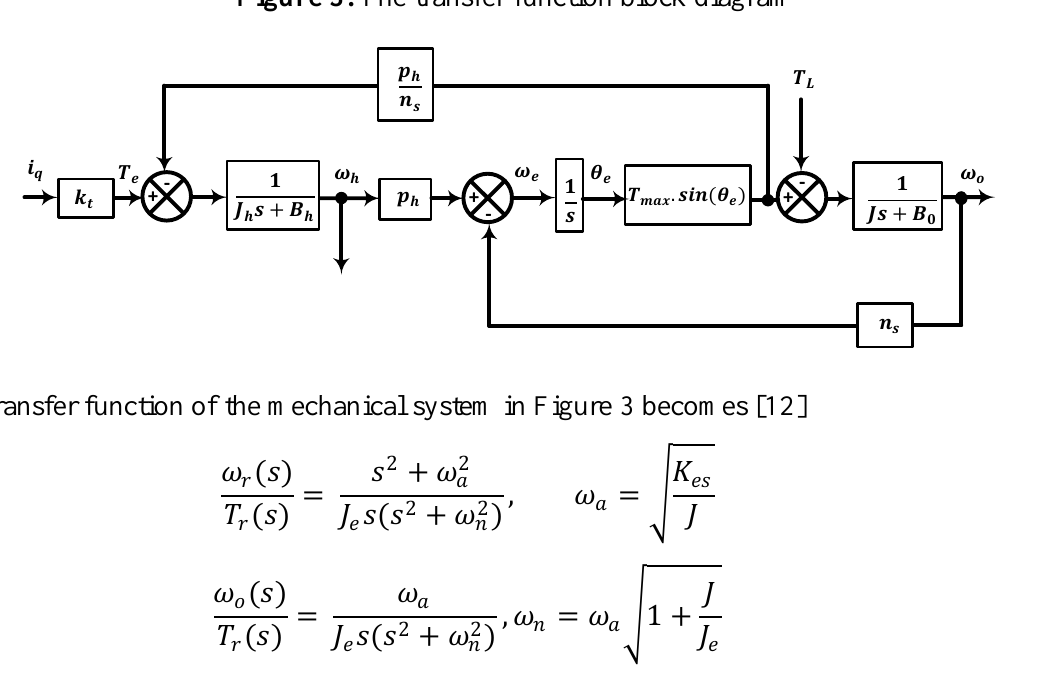
Figure 3. The transfer function block diagram